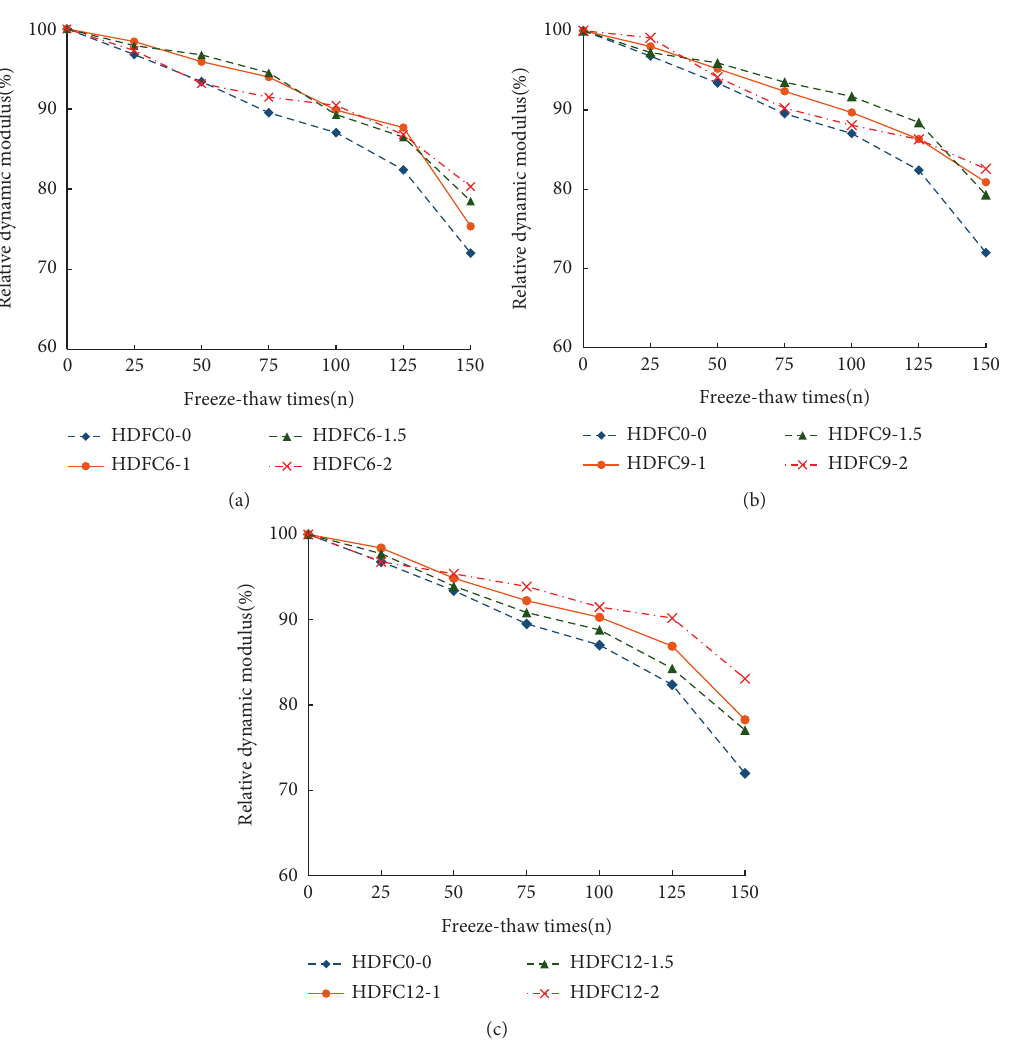
Figure 2: The change law of relative dynamic elastic modulus of HDFC. (a) HDFC6-1-HDFC6-2. (b) HDFC9-1-HDFC9-2. (c)